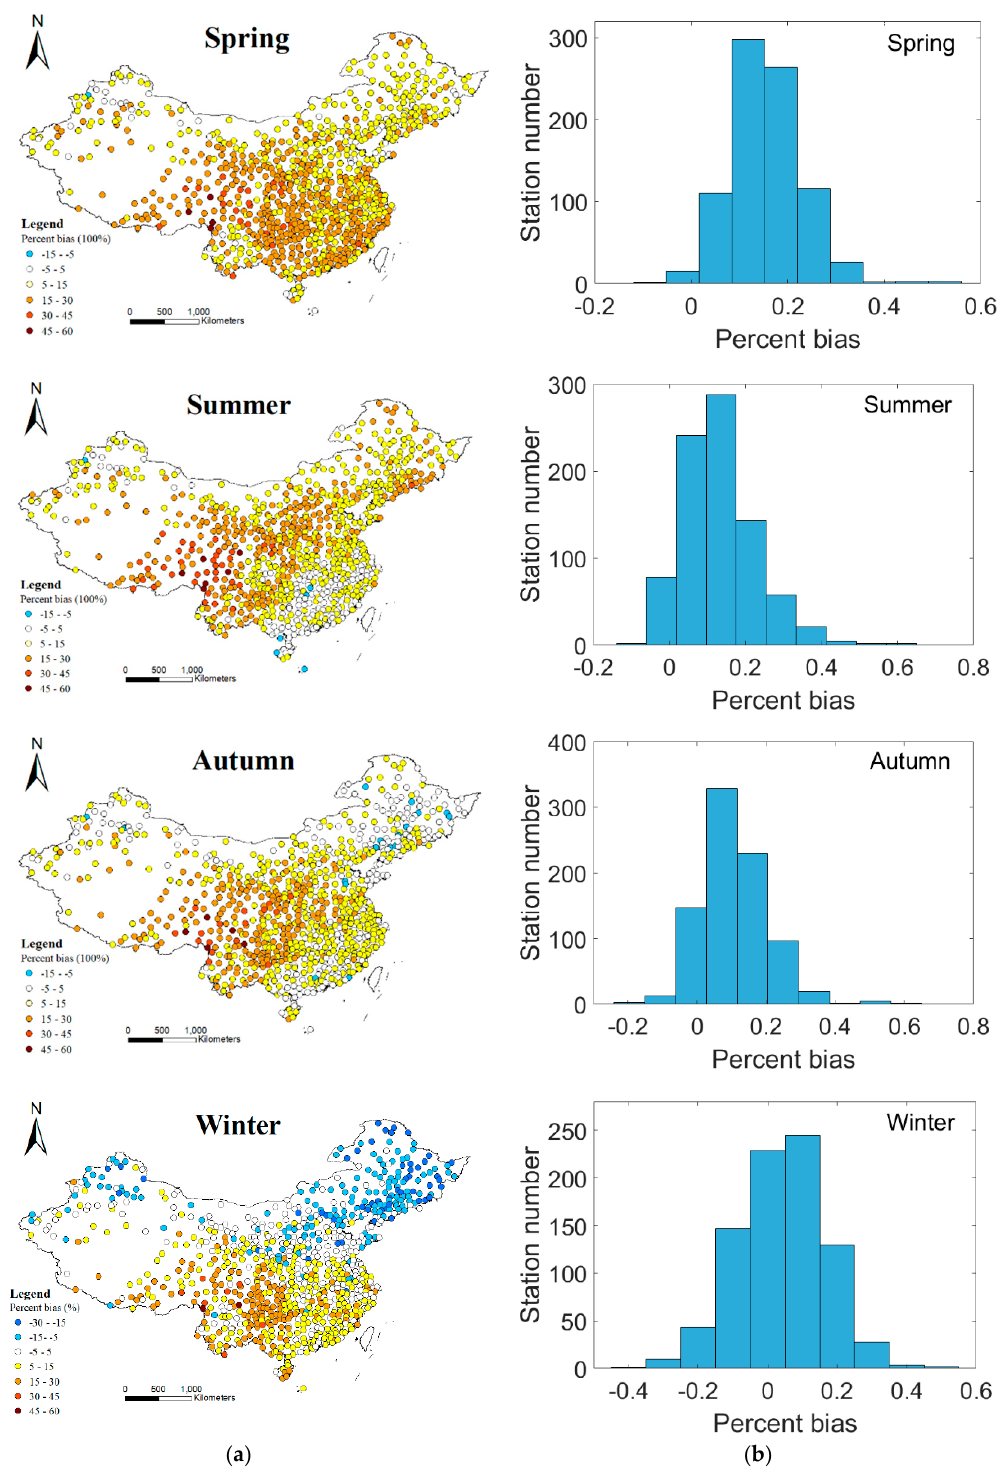
Figure 5. Spatial distribution of percentage bias showing the accuracy of mean seasonal potential evapotranspiration (PET) estimated using CMADS datasets, PET_cma ( a ) and the frequency distribution of percentage bias ( b ).